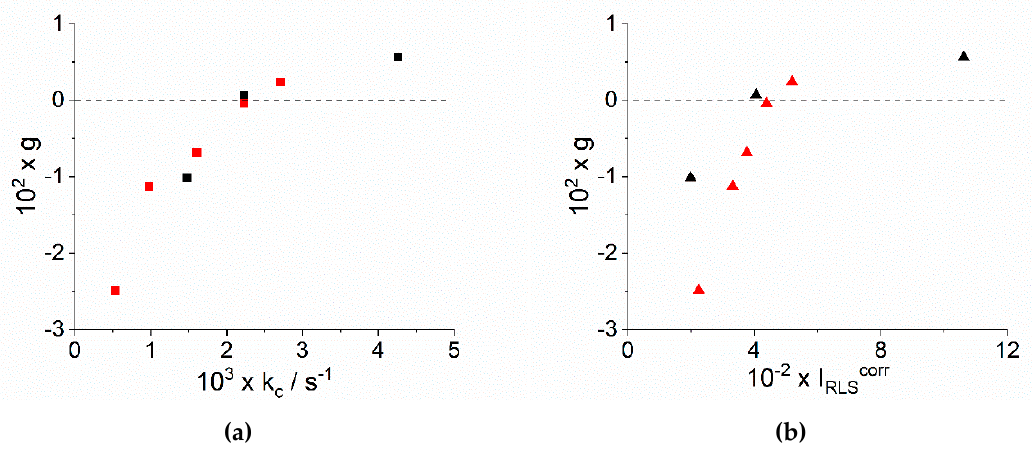
Figure 8. ( a ) Plot of the extinction values and the relative full width at half maximum, ( b ) FWHM for the J-band at 490 nm of the final UV/Vis spectra as function of [H + ] and fixed ionic strength (IS = 0.6 M).